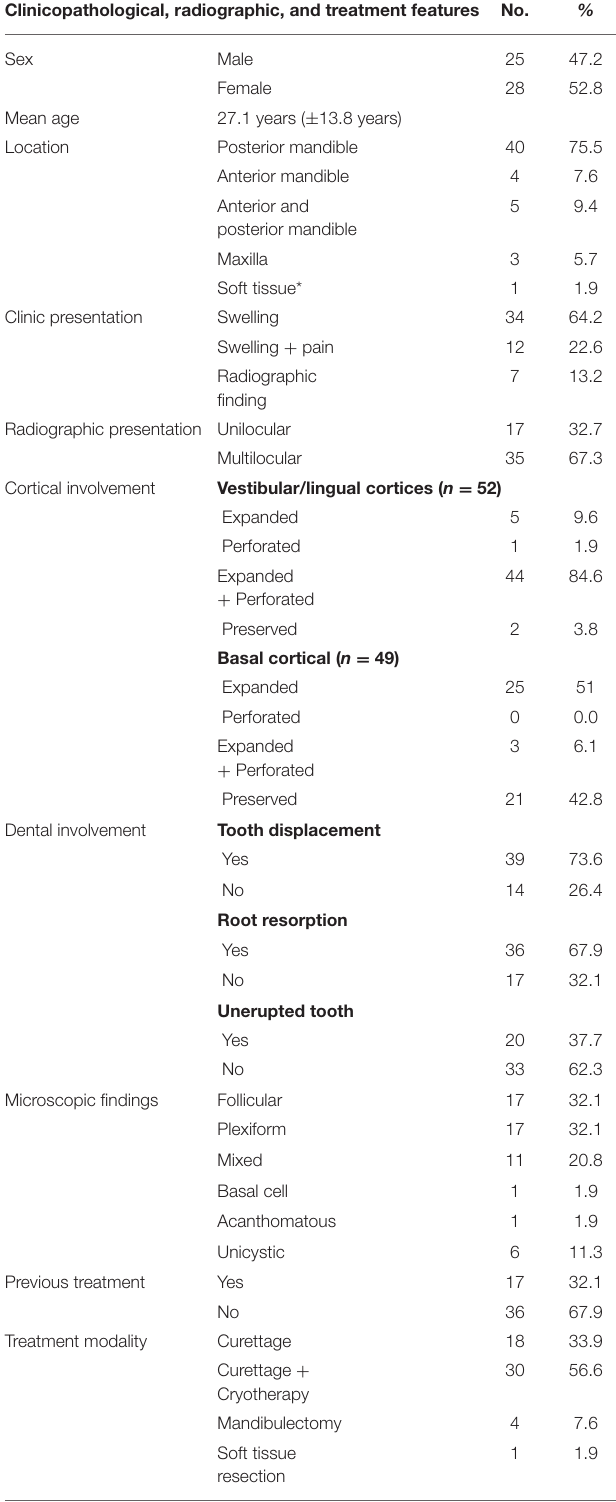
TABLE 1 | Clinicopathological, radiographic, and therapeutic features of the patients affected by the ameloblastoma. Clinicopathological, radiographic, and treatment features